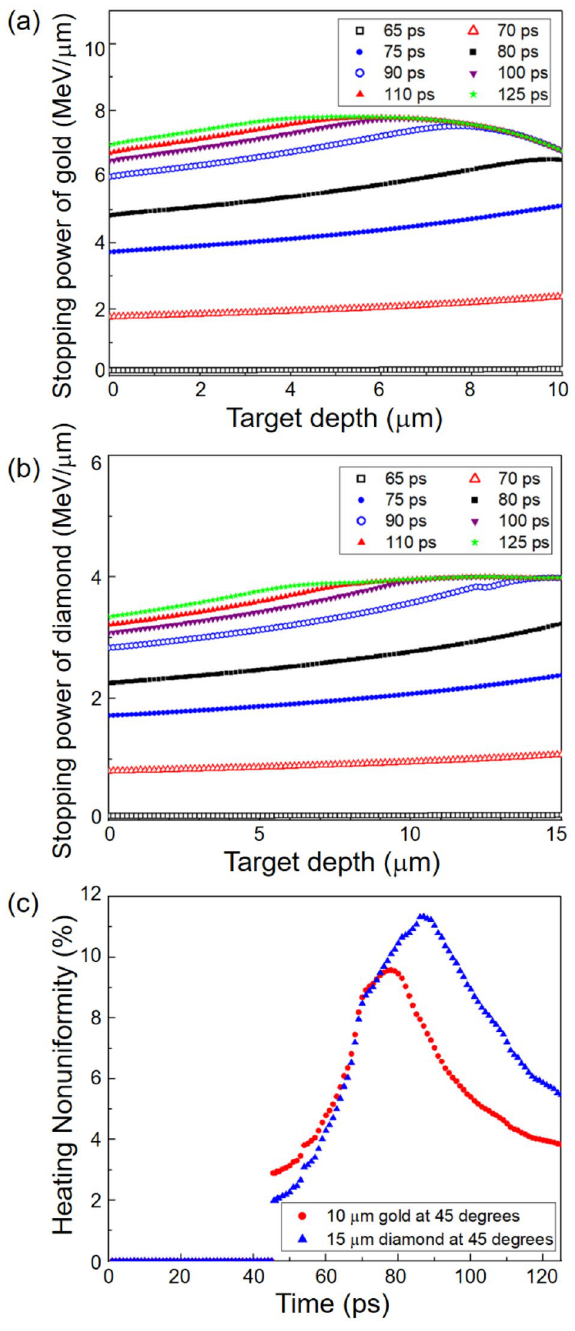
Figure 3. The time evolutions of ( a ) the stopping power of a 10-μm-thick gold sample at an angle of 45° and ( b ) the stopping power of a 15-μm-thick diamond sample at an angle of 45° are plotted as functions of the target depth from 65 to 125 ps. ( c ) The heating nonuniformities of the gold and diamond samples are plotted as functions of time in the 0–125 ps